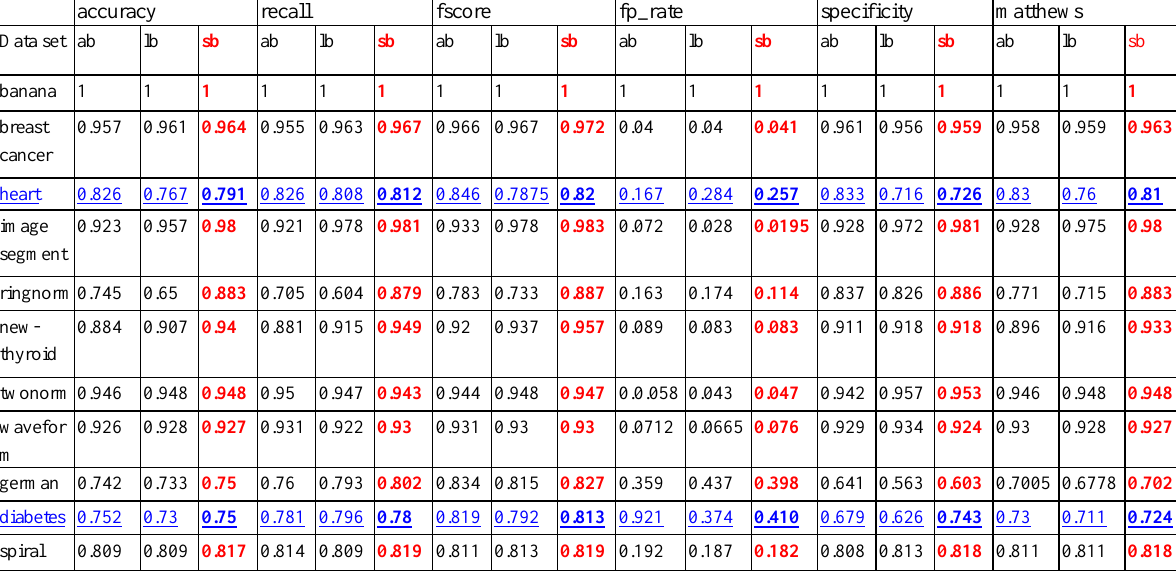
Table 4. Six evaluation criterions of 3 algorithms over 11 datasets: the average value of 5-fold-cross